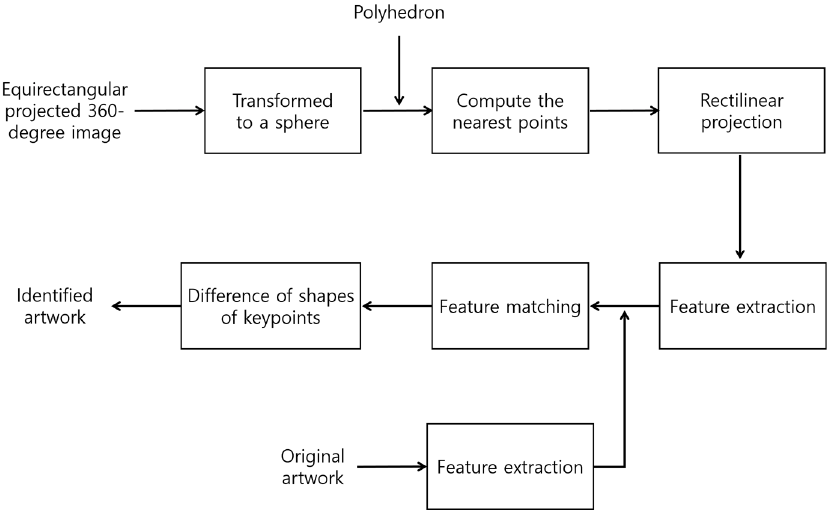
Figure 1. Flowchart of the proposed method.